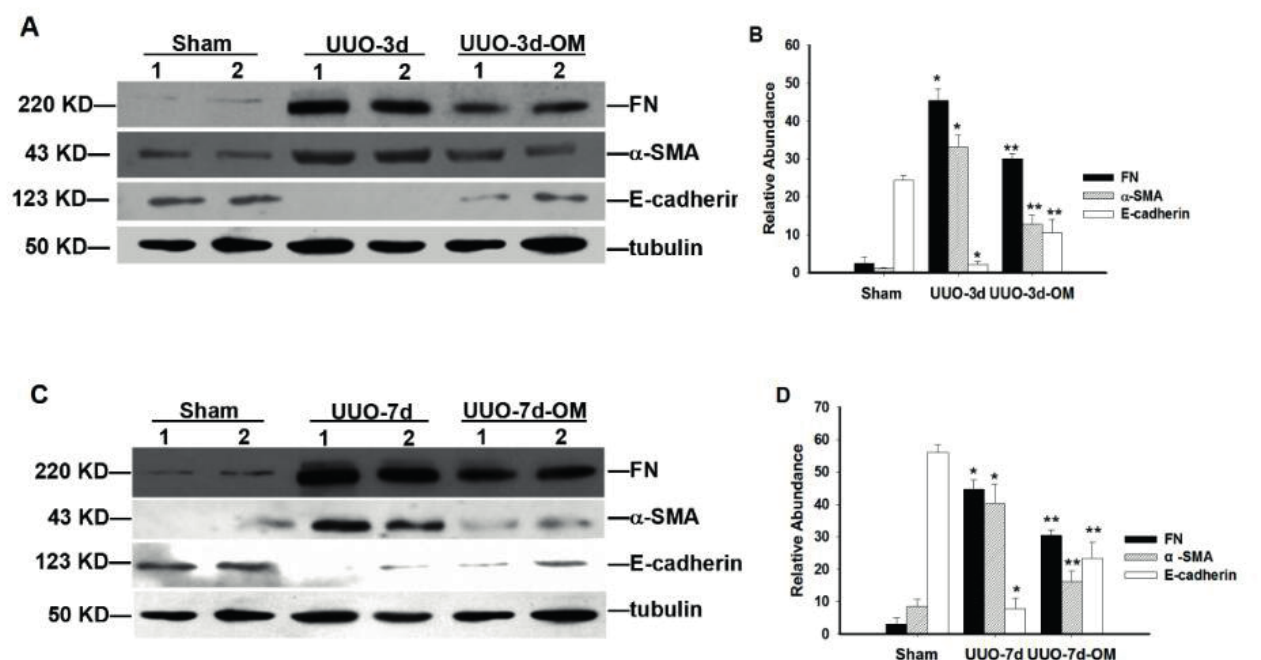
FIGURE 3 - OM inhibits FN, α -SMA and preserves epithelial E-cadherin expressions in UUO groups Western blo t analyses for FN, α -SMA and E-cadherin expressions in renal tissues. Increased labeling of FN and α -SMA were observed in UUO-3d and UUO-7d groups, while those were noted to be decreased by OM treatment. E-cadherin labeling intensity was decreased in model mice, whereas it was also recovered in the OM treatment group (A and C). Graphic presentation of the relative expressions of FN, α -SMA and E-cadherin (B and D). The graph summarizes densitometric analysis of 3 independent technical experiments. The values are represented as the density of FN, α -SMA or E-cadherin vs tubulin control. *: P<0.05 vs. sham group, **: P<0.05 vs. UUO-3d